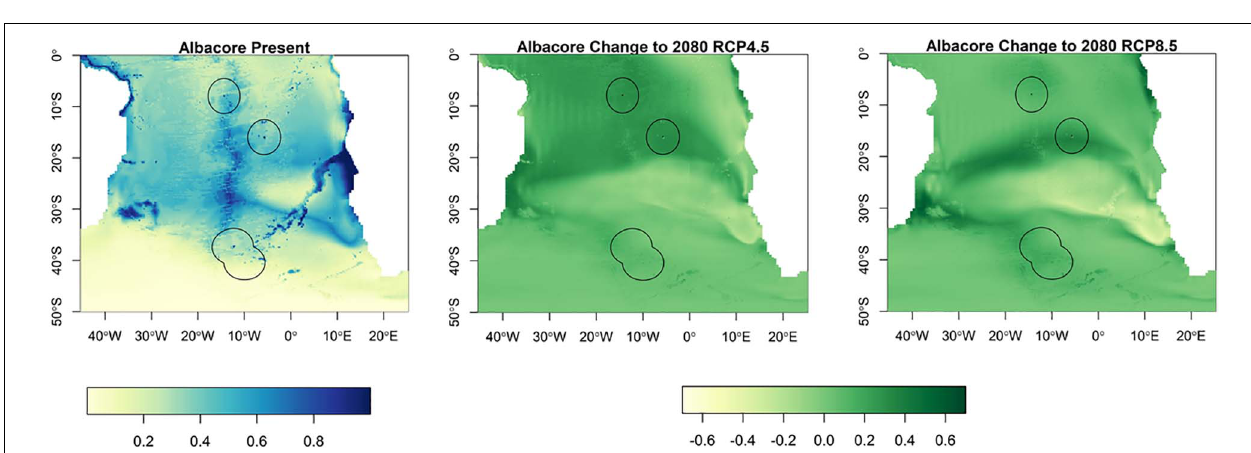
FIGURE 2 | The habitat suitability for southern bluefin tuna from Maxent in the South Atlantic for the present day and the change to 2080 under RCP4.5 and RCP8.5. The EEZs are shown in the black outline. The yellow areas are the most suitable, and the dark blue the least suitable.